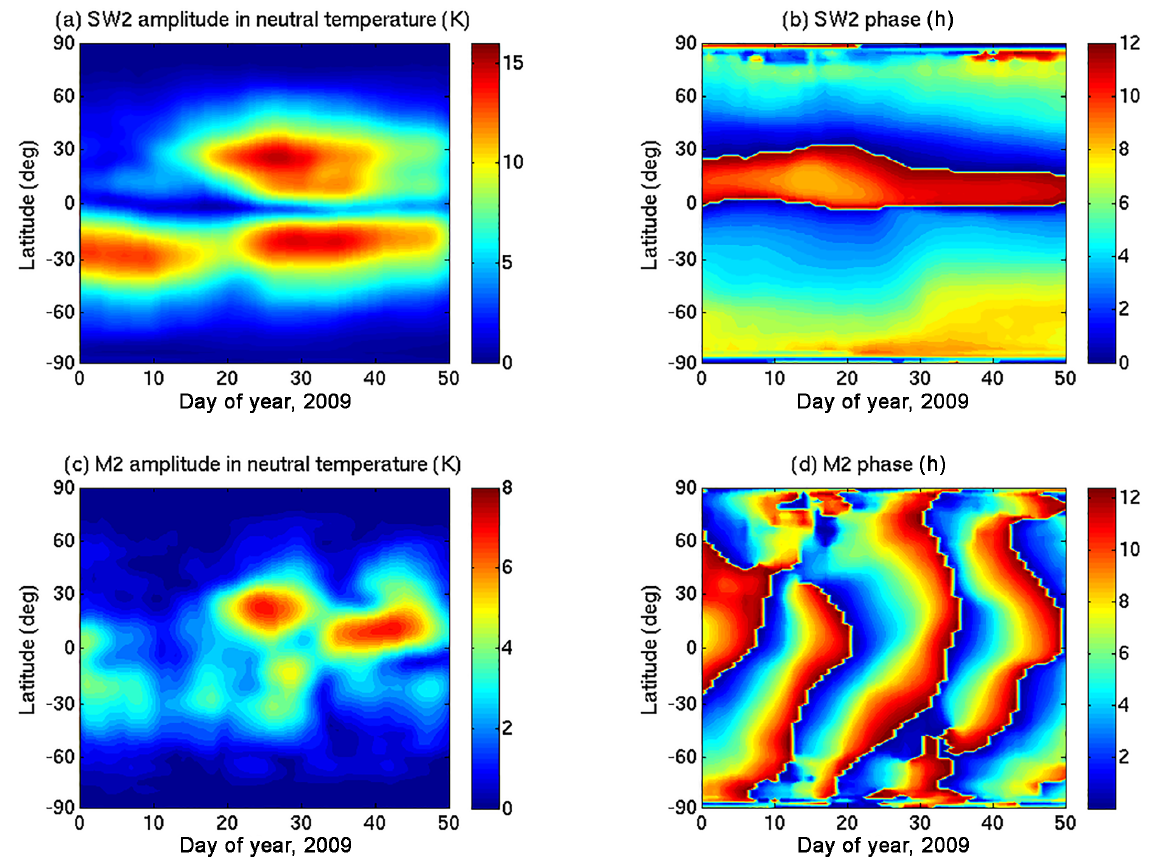
Figure 7. The amplitude (a) and phase (b) of the SW2 tide in neutral temperature at ∼ 120km altitude during the 2008–2009 SSW event (simulations from Pedatella et al., 2018a). The amplitude and phase of the M2 tide during the same period are presented in (c) and (d) ,